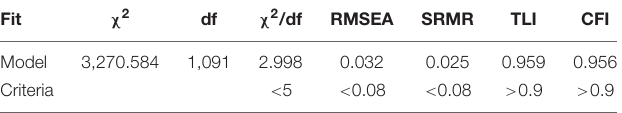
TABLE 2 | Fit index for structure equation